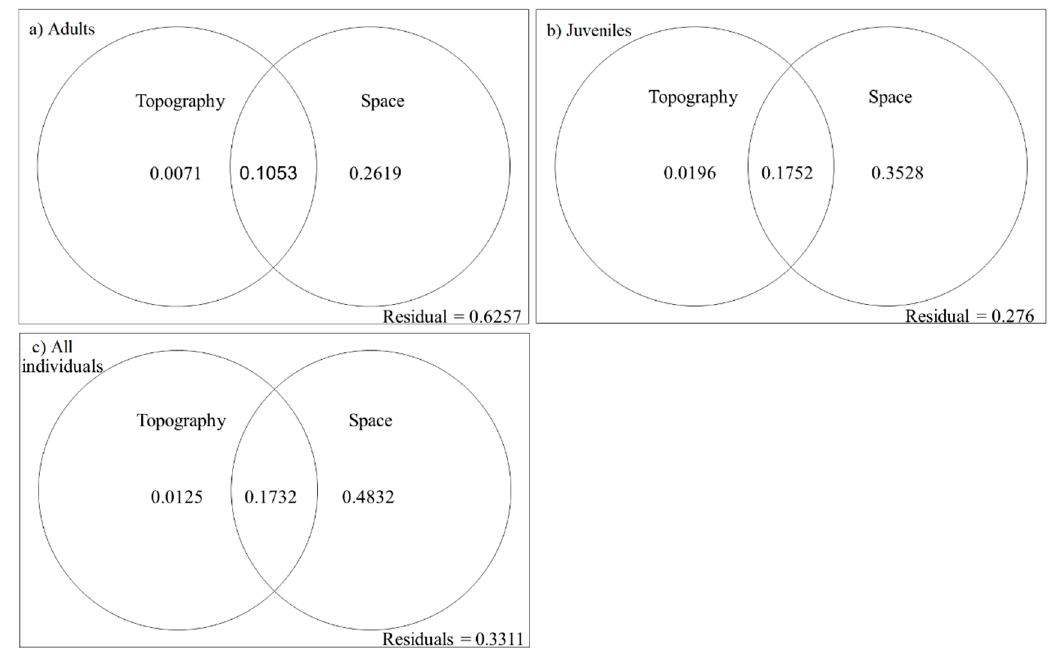
Figure 5. Variation partition of the 16 dominant tree species. The numbers in the circles indicate the portion of variation explained by topographic and spatial variables, respectively.